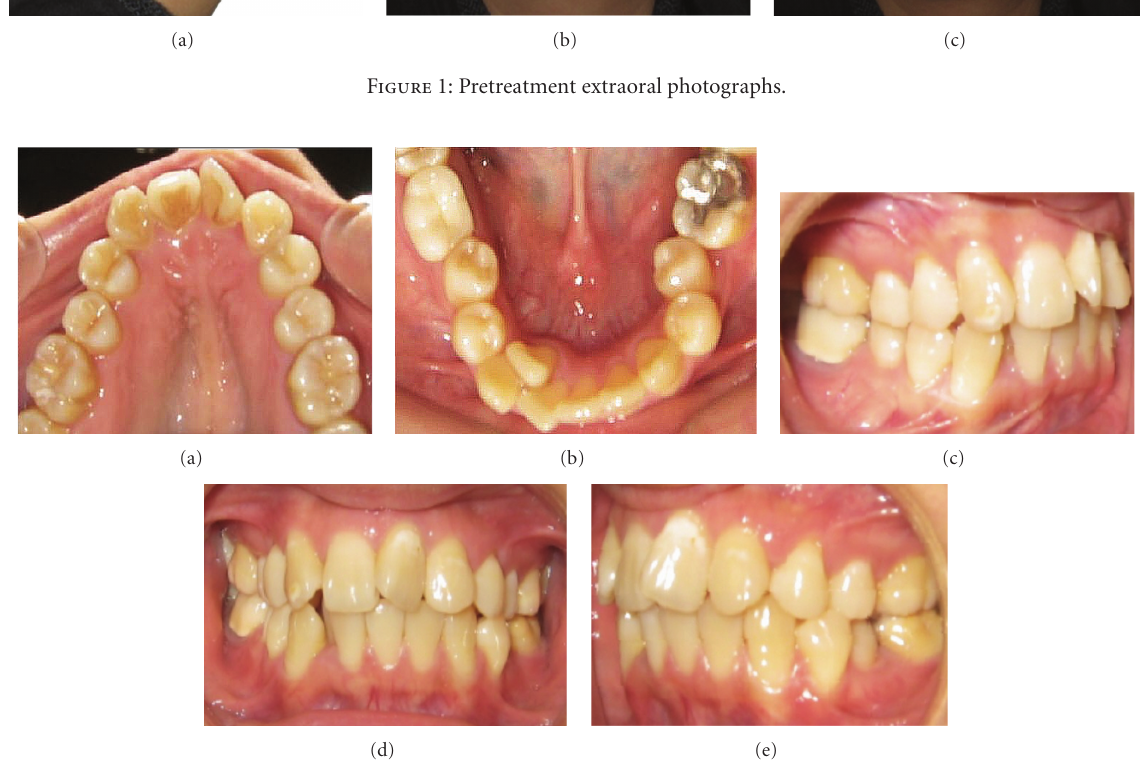
Figure 2: Pretreatment intraoral